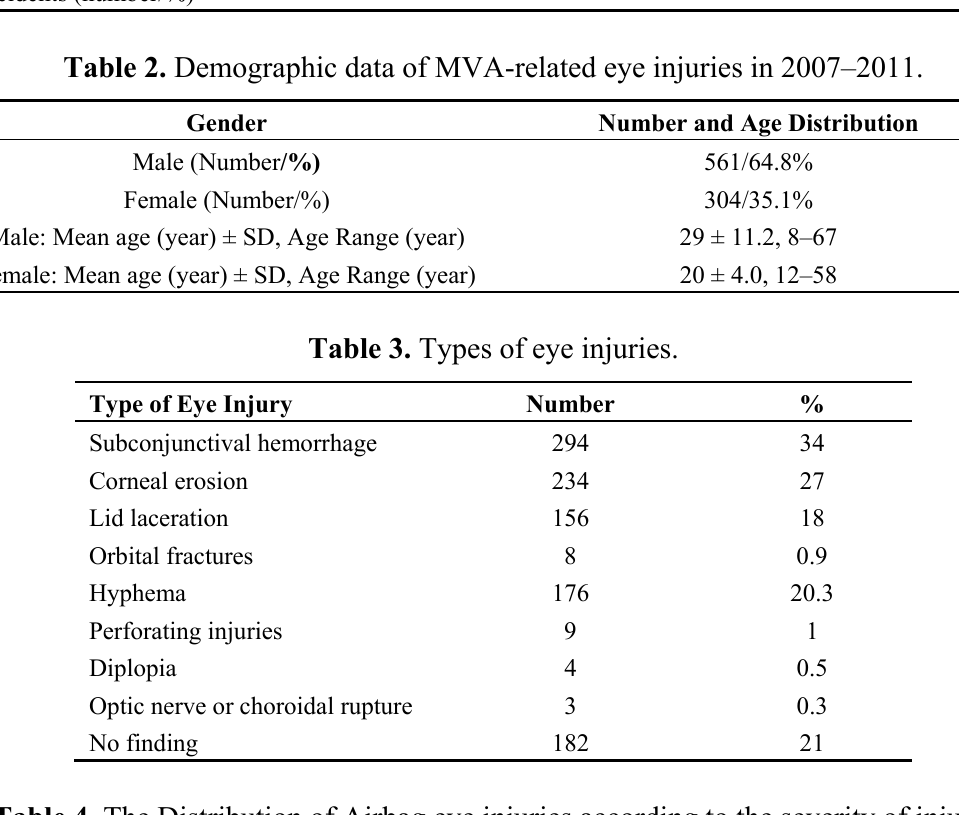
Table 4. The Distribution of Airbag eye injuries according to the severity of